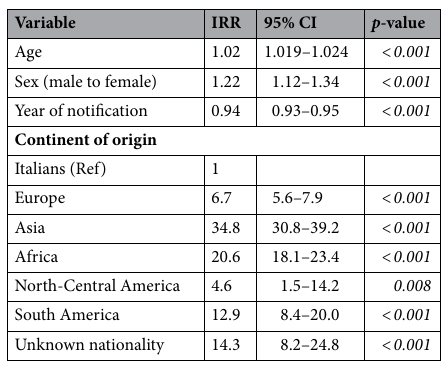
Table 3. Multivariate Poisson regression analysis of variables associated with TB diagnosis; Incidence Rate Ratio (IRR), 95% confidence intervals (95% CI) and p -value for age, sex, continent of origin and year of notification. Significant values are in